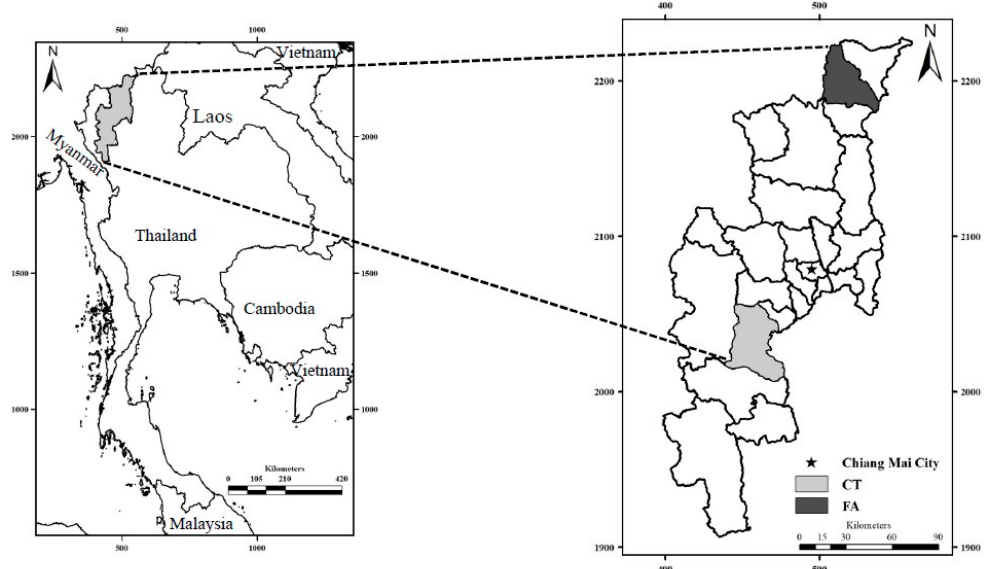
Figure 1. Maps of Thailand (left) and Chiang Mai Province, showing the Fang (FA) and Chom Thong (CT) districts, located at 19°54 ′ 26 ″ N, 99°2 ′ 26 ″ E and 18°25 ′ 2 ″ N, 98° 40 ′ 27 ″ E, respectively. The participants were interviewed face-to-face using a structured questionnaire. Factors